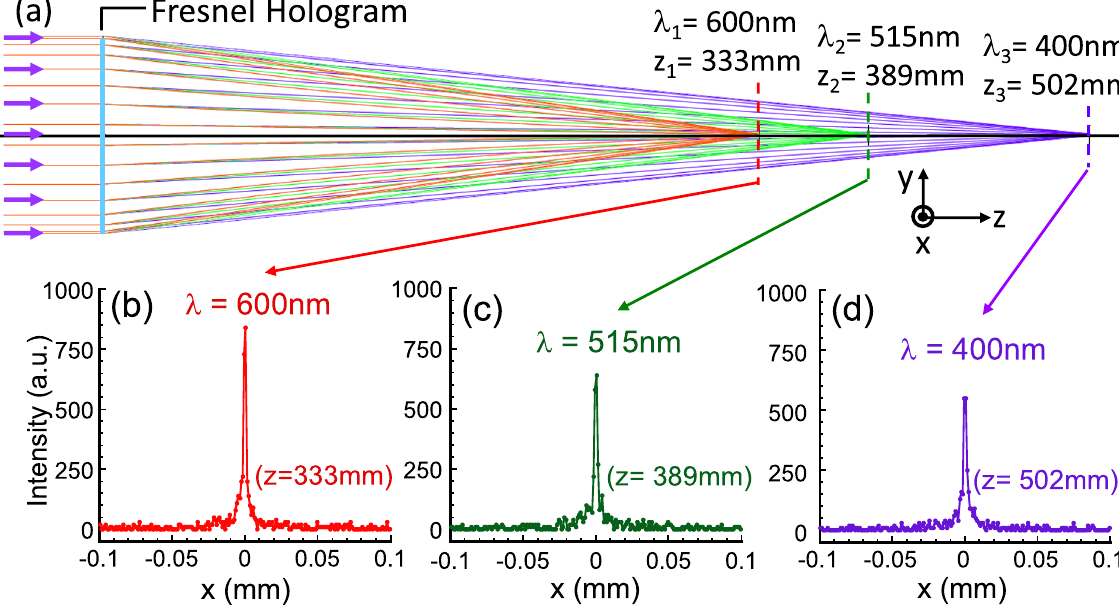
Figure 3. A simulation result of the reconstructed image at three different wavelength of light, λ 1 = 600, λ 2 = 515 and λ 3 = 400 nm. ( a ) The effect of light focusing and dispersion by a Fresnel Hologram simulated by the ZEMAX software. ( b – d ) are the simulated intensity distribution of light versus x-axis of three different ls at their respective focal planes, z 1 = 333, z 2 = 389 and z 3 = 520 mm,